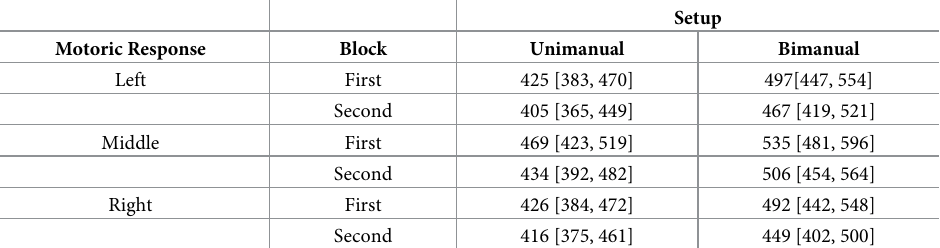
Table 1. Estimated means [and 95% confidence intervals] for response time (ms) as a function of setup, Motoric Response and Block (Simple